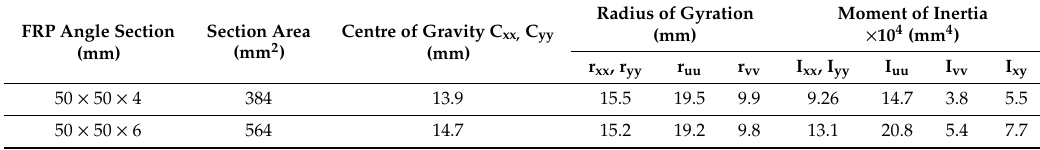
Table 2. Geometry of the glass fiber reinforced polymer (GFRP) angle sections .